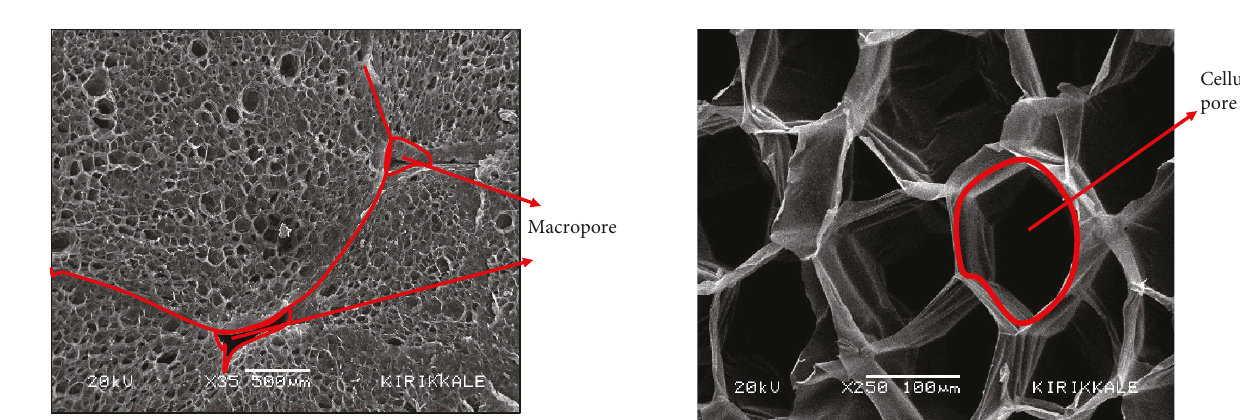
Figure 5: X250 microstructure image for the expanded polystyrene with a density value of 16 kg/m 3